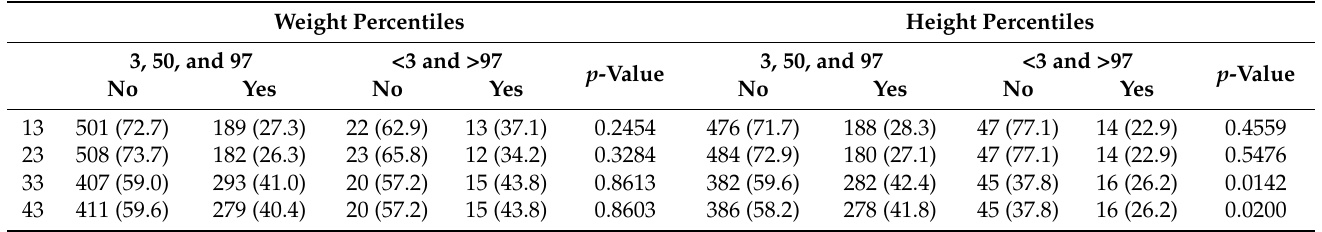
Table 4. Eruption of the canines and its relation by hemiarch with weight and height percentiles. Weight Percentiles